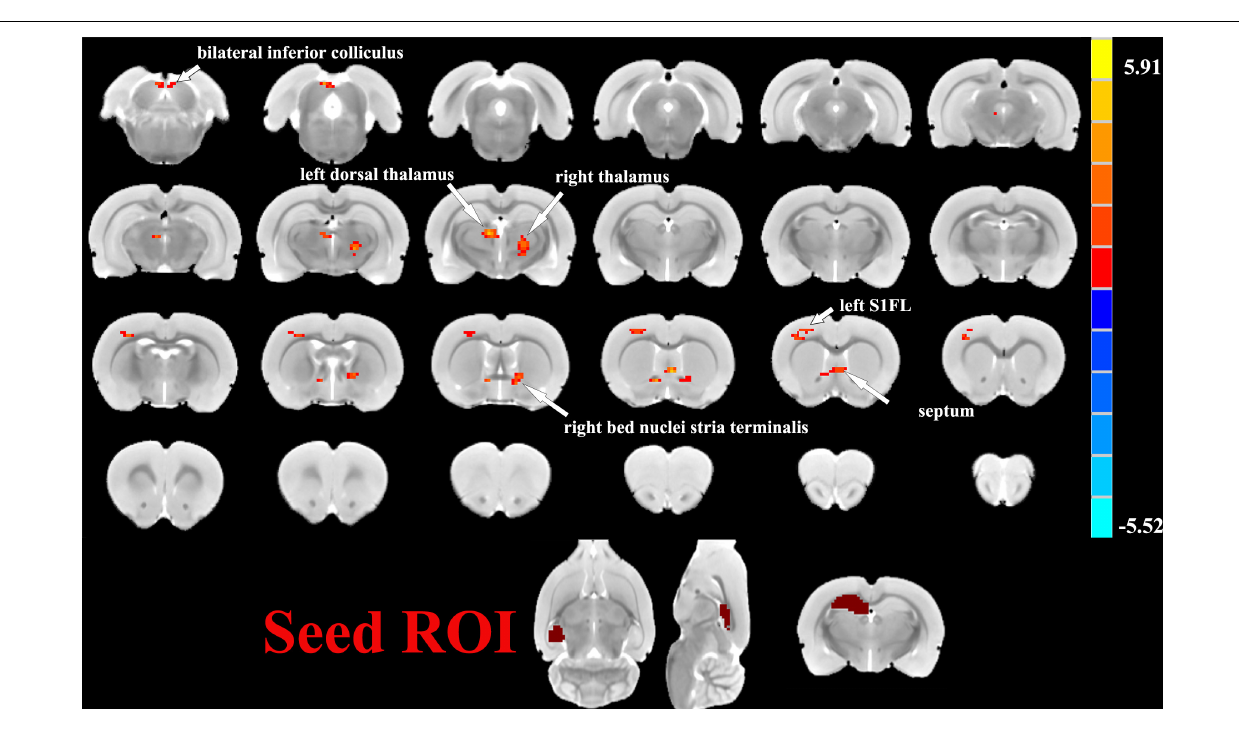
FIGURE 4 | Two sample t -test functional connectivity (FC) analysis selecting the left hippocampus as seed between the SAE and control groups. Within the SAE group, FC analysis selecting the left hippocampus as the seed point showed significantly increased FC in thalamus, septum, bed nuclei stria terminalis (BNST), left primary forelimb somatosensory cortex (S1FL) and inferior